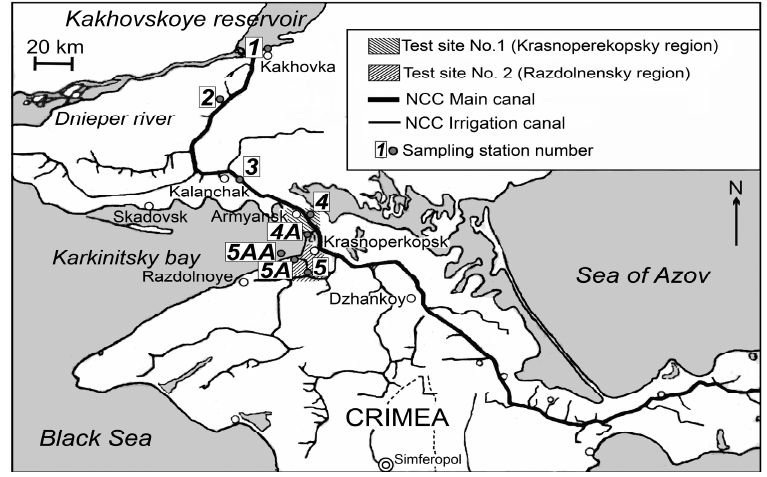
Figure 1. Map-scheme of sampling in the area of the North Crimean Canal.